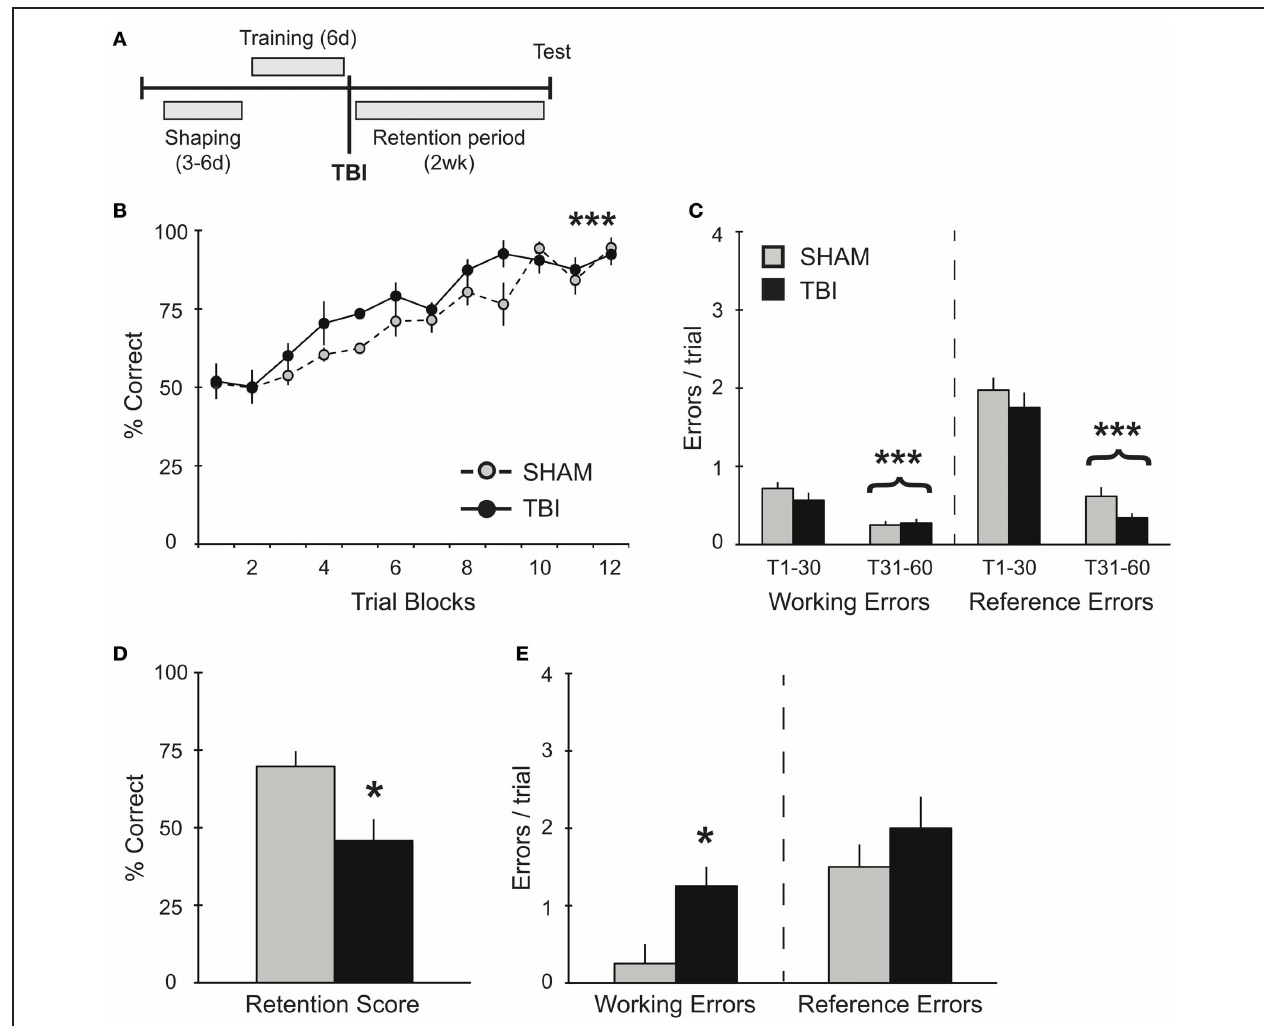
improvement in percent correct and significant decreases in working and reference memory errors across training days for both groups ( ∗∗∗ p < 0 . 001). (D,E) During retention testing, TBI impaired memory retrieval with a decrease in percent correct score and an increase in working memory errors ( ∗ p < 0 .